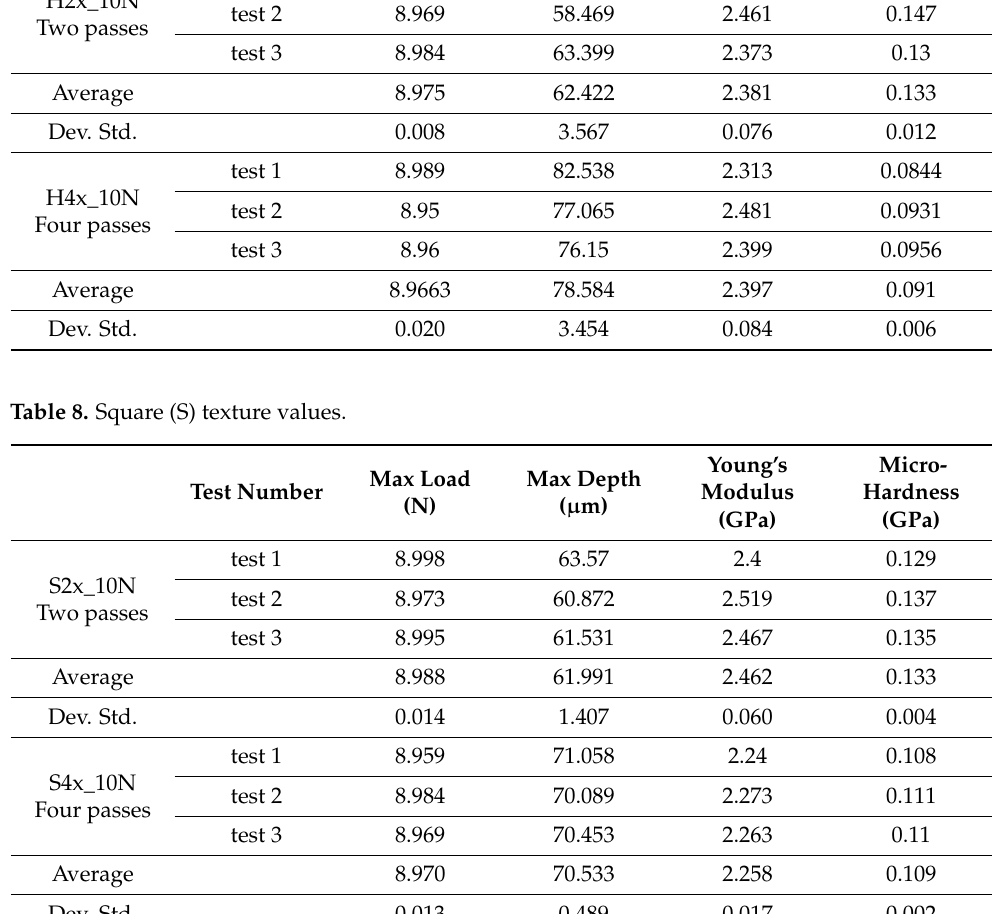
Figure 8. Square texture microindentation test (4 passes): 1, 2, 3—measurements. Table 7. Hexagonal (H) texture values.